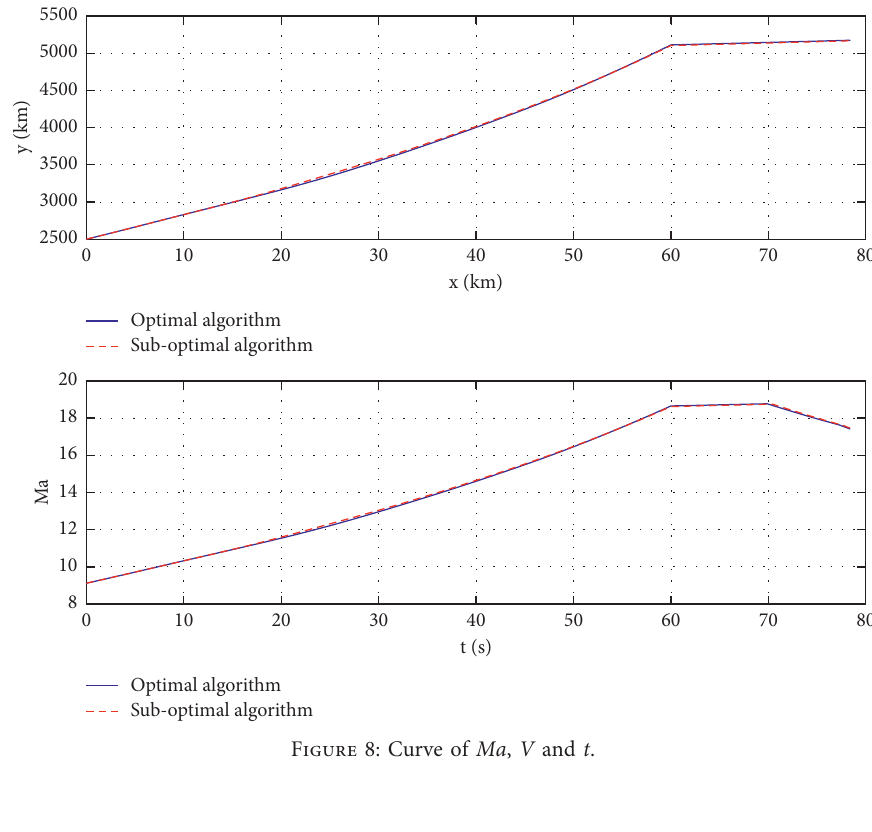
Figure 8: Curve of Ma , V and t .